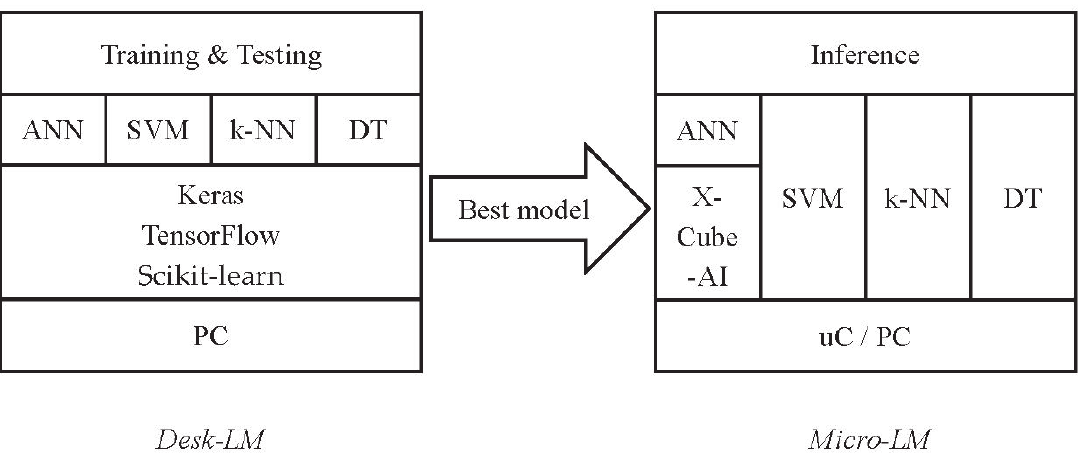
Figure 1. Block diagram of the Edge Learning Machine system architecture.